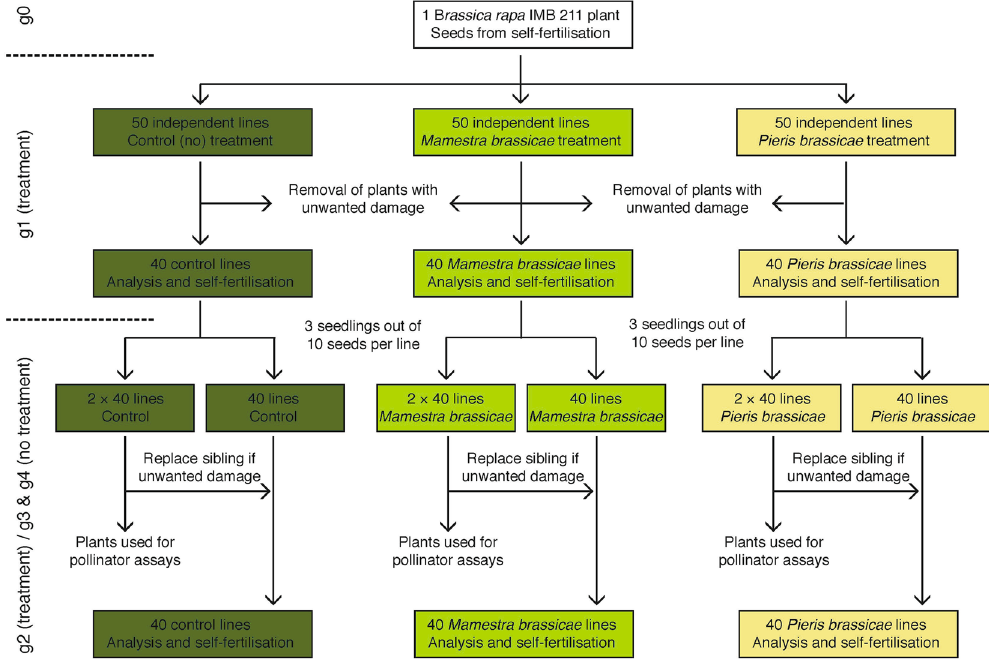
Figure 4. Propagation scheme showing the initial plant (g0), the two generations with herbivore treatment (g1 and g2) and the two generations without herbivory (g3 and g4) of this